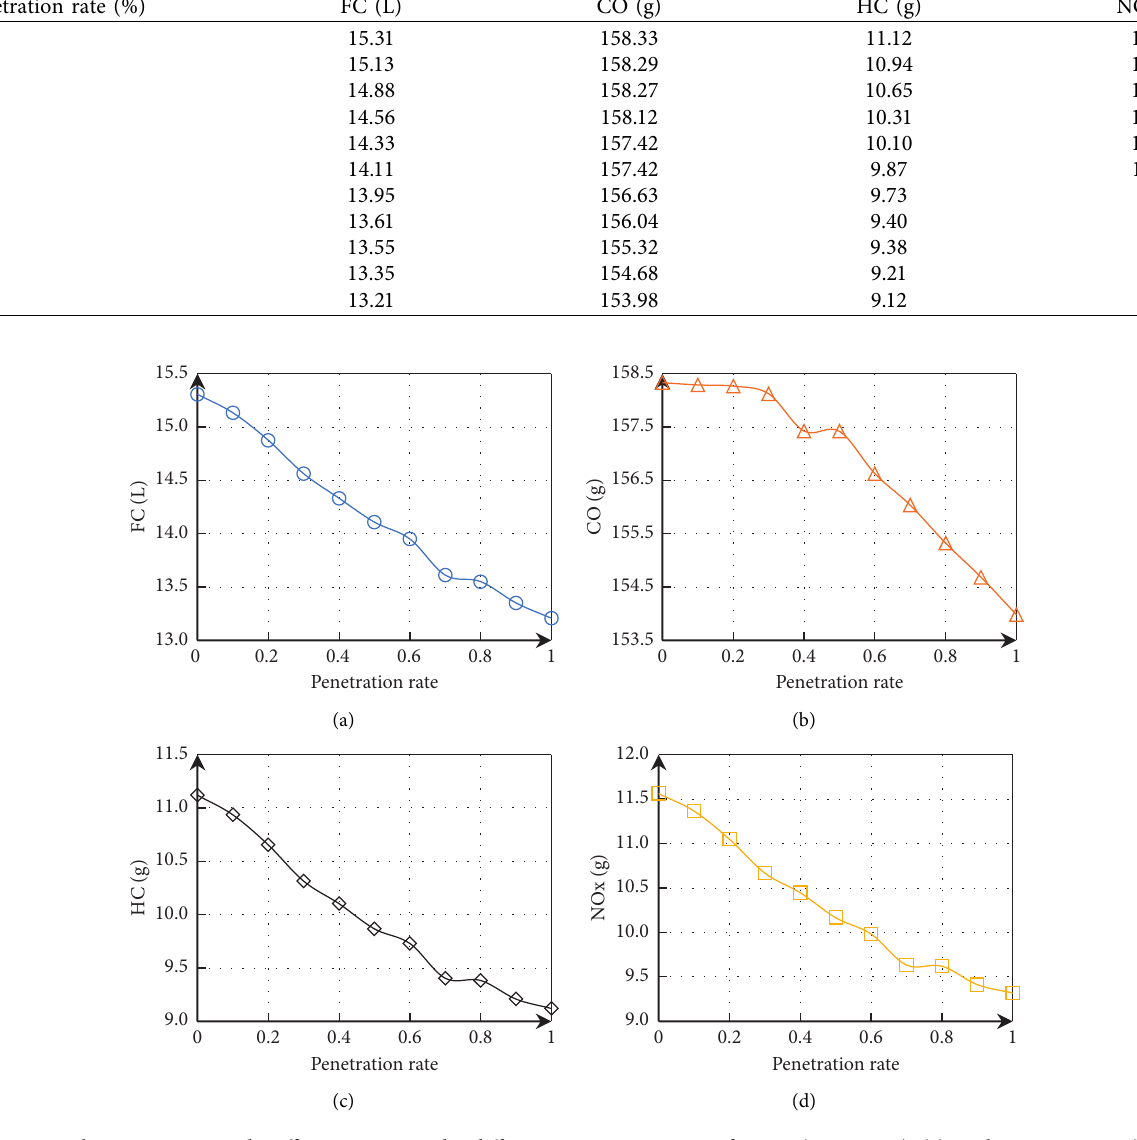
Figure 5: Fuel consumption and traffic emissions under different penetration rates of CAVs (Scenario 1). (a) Fuel consumption. (b) CO. (c) HC. (d) NOx.